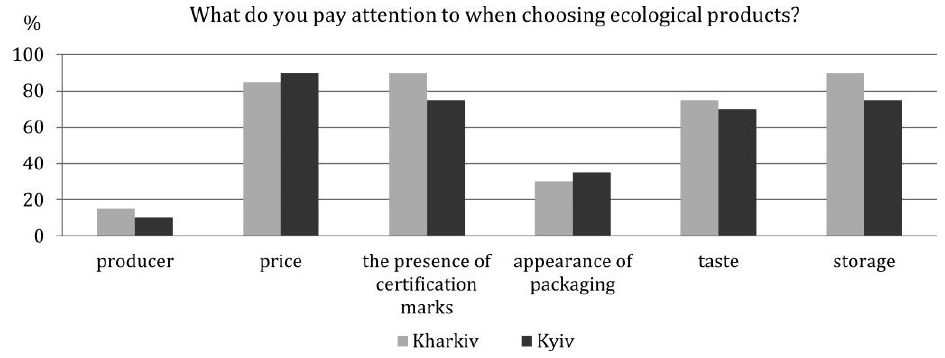
Fig. 6. Important characteristics for buying an ecological product (Source: author's research)